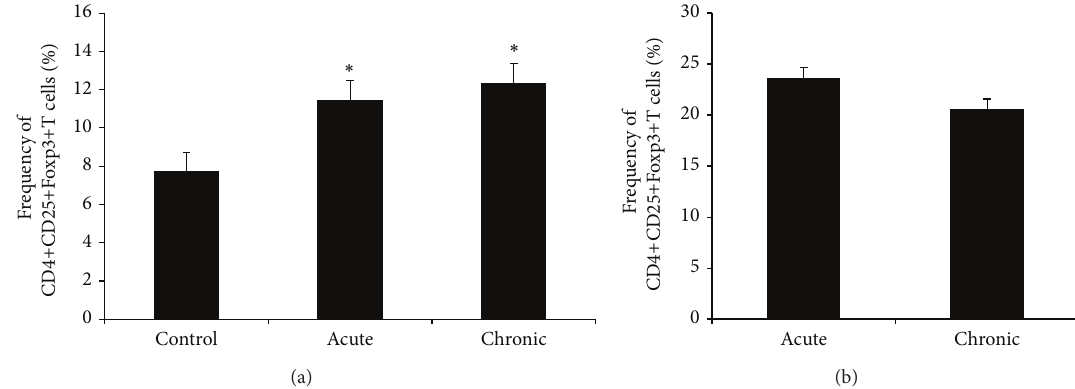
Figure 5: Frequency of CD4+CD25+Foxp3+ T cells in spleen (a) and in CNS (b). The percentage of CD4+CD25+Foxp3+ T cells was determined during acute and chronic stages of EAE by flow cytometric analysis. Data were presented by mean ± SE of 6 mice and representative of two independent experiments. ∗ 𝑃 < 0.05